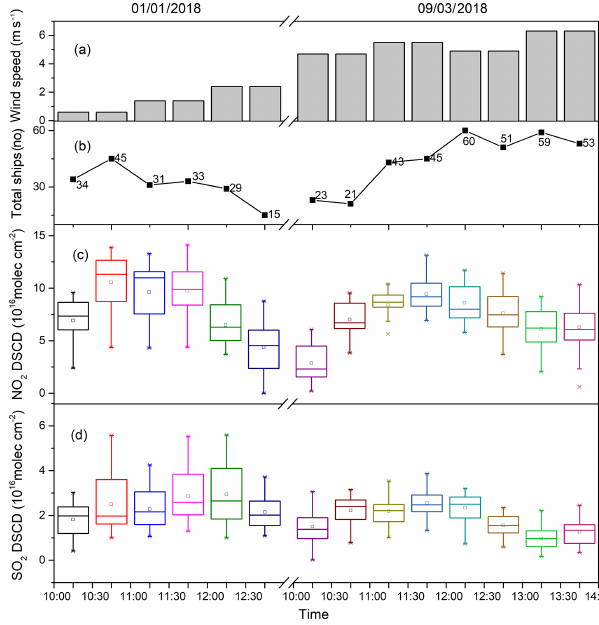
Figure 7. The 30min averaged wind speed, ship traffic volume, ob- served NO 2 and SO 2 DSCDs from 10:00 to 13:00LT on 1 January and 10:00 to 14:00LT on 9 March at the Wusong Wharf measure- ment site. The hollow squares in the middle of the boxes represent the mean values, and the solid lines in the middle of the boxes rep- resent the medians. The whiskers extend from each end of the box to the internal and external limits. “–” represents the maximum and minimum, and the “ × ” symbols are the 1% and 99% quantiles. The upper and lower edges of the boxes are the 25% and 75% quantiles,